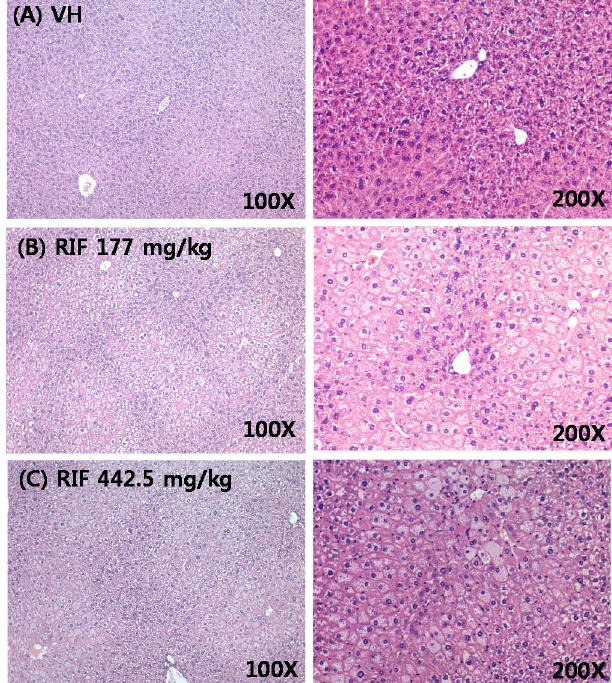
Figure 2. Histopathology of liver tissue in male ICR mice. The liver tissue of vehicle ( A ), rifampicin-treated at 177 mg/kg ( B ); and rifampicin-treated at 442.5 mg/kg ( C ) for 14 days at 100× and 200× magnification.